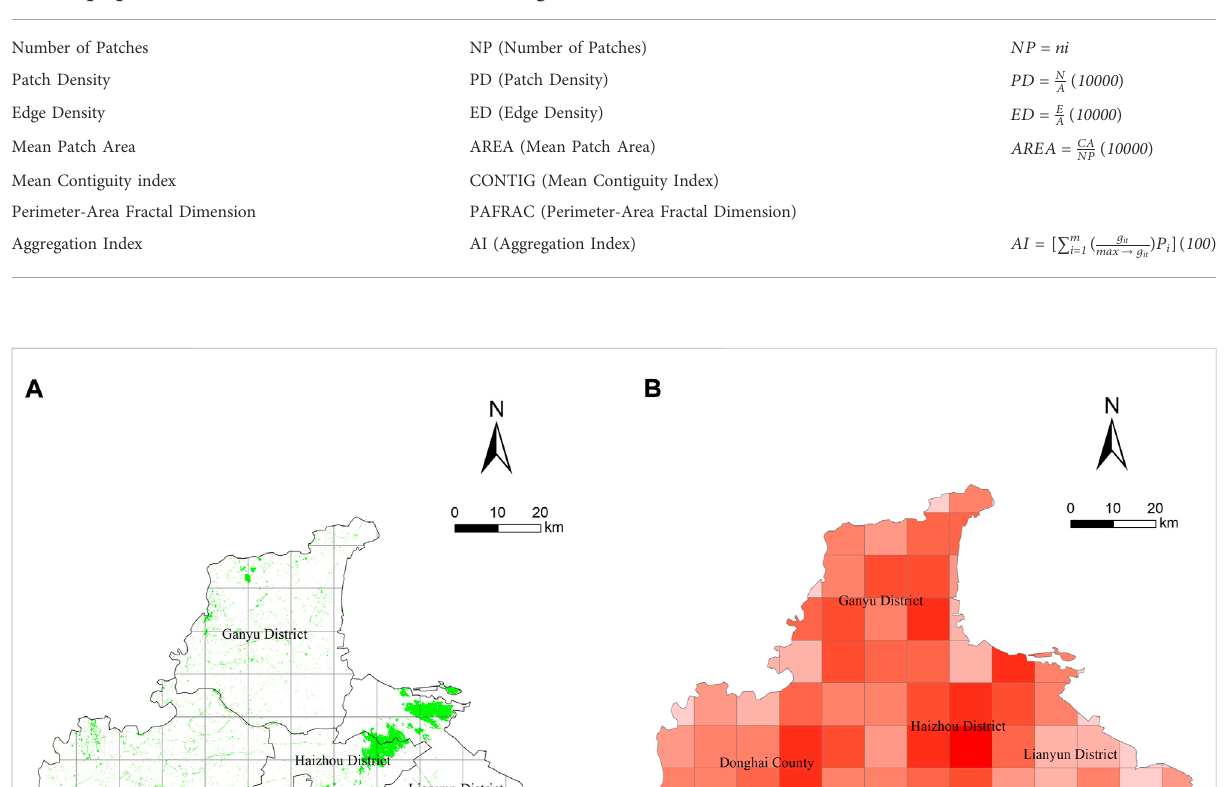
TABLE 1 Selected calculation formulas of landscape pattern indices.